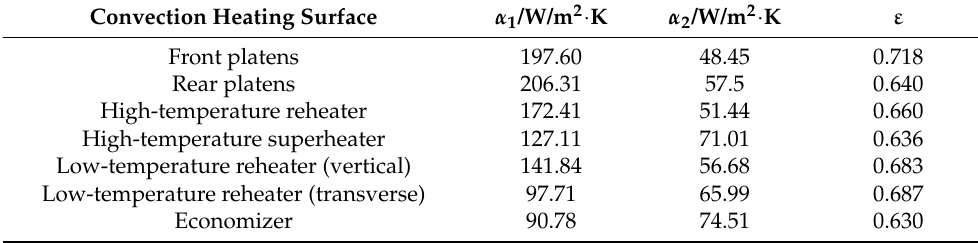
Table A1. Heat exchange coefficients and ash thermal resistance of convective heat transfer